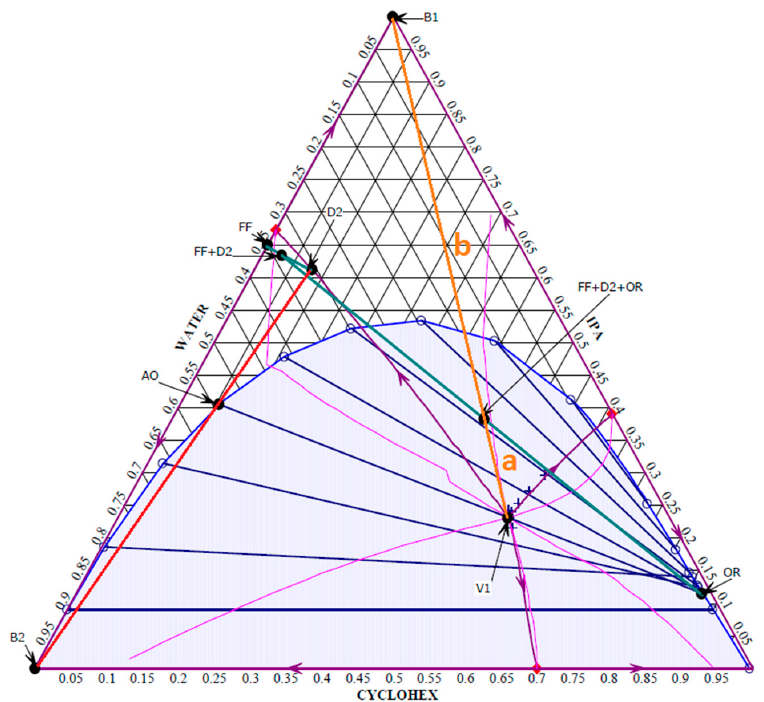
Figure 6. Ternary map at 1 atm for the system 2-propanol (IPA) + water (WATER) + cyclohexane (CYCLOHEX), showing the points corresponding to the streams involved in the process shown in Figure 1, the material balance line for the HAD column (in orange), segments a and b for the calculation of the V1 flowrate (Equation (1)), and the material balance line for the recovery column (in red).